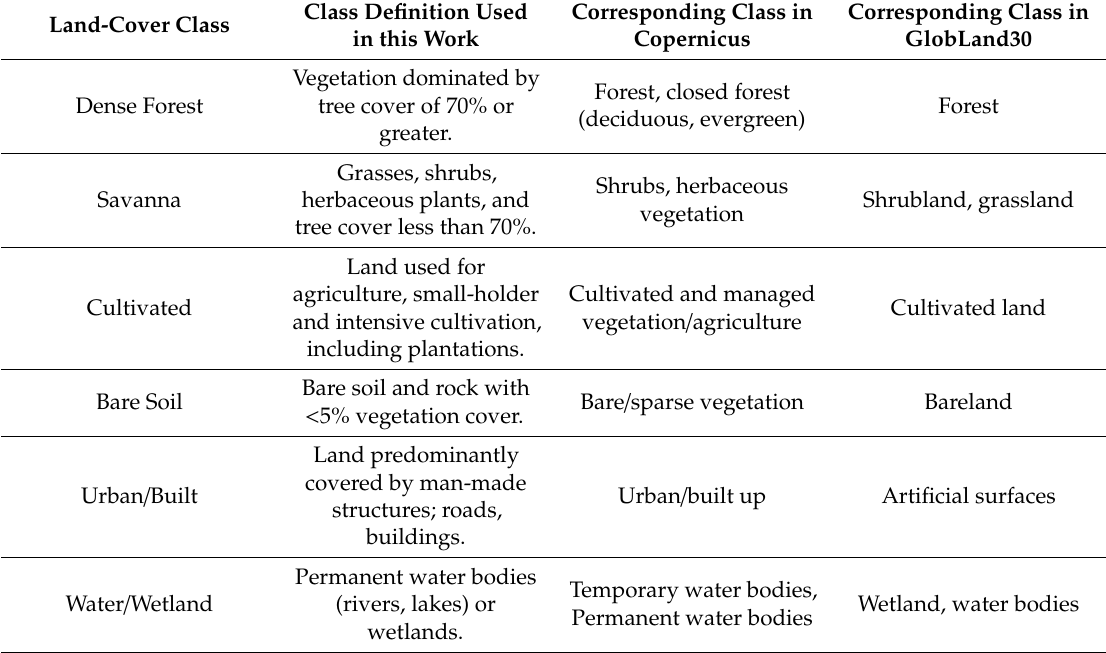
Table 1. Land-cover classification scheme and corresponding classes in Copernicus and GlobeLand30 map